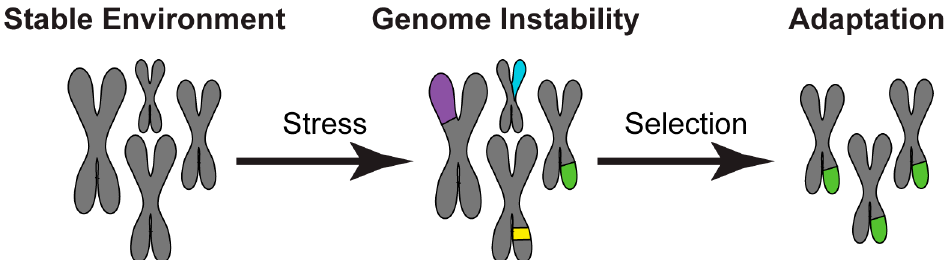
Figure 1. Stress-induced genome instability as a key adaptive mechanism. In a stable environment, the genomic organisation (grey) of microbial organisms allows optimal growth. Environmental changes are sensed as a stress and induce genome instability. The increased genetic diversity allows selection of genotype(s) (grey and green) that are better adapted in the new environment.